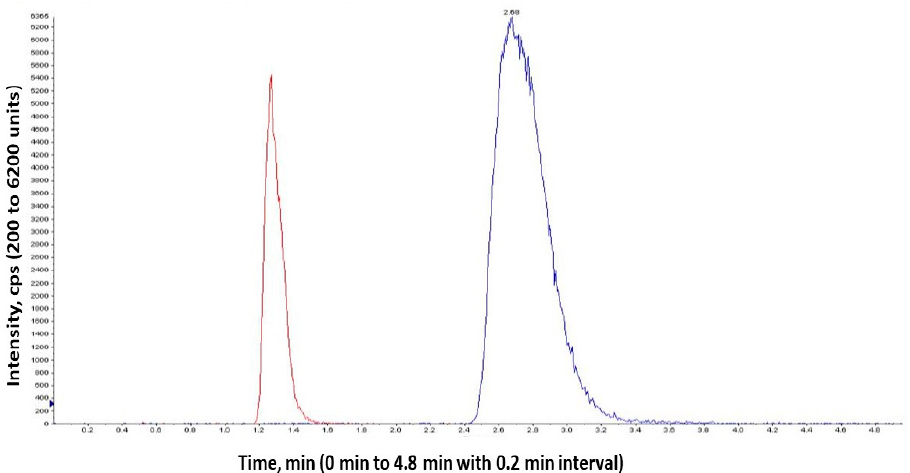
Figure 6. LCMS/MS chromatograms of hydrochlorothiazide (IS) and aliskiren hemifumarate.